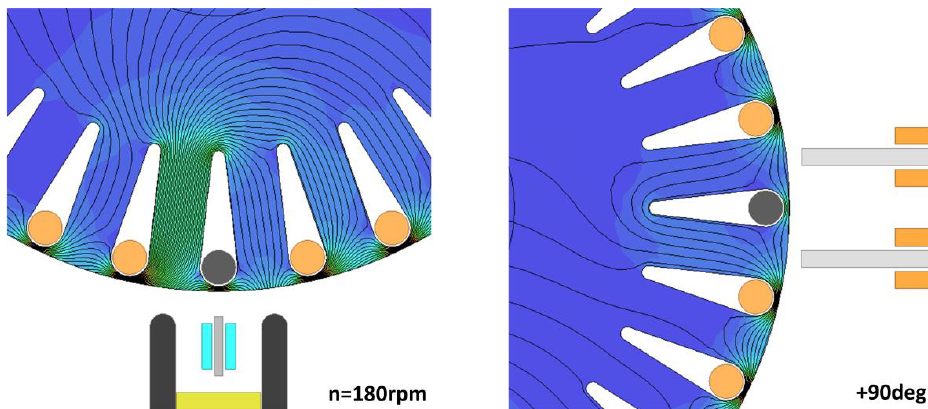
Figure 6. Magnetic flux density distribution on the 2D FEM model of the test rotor